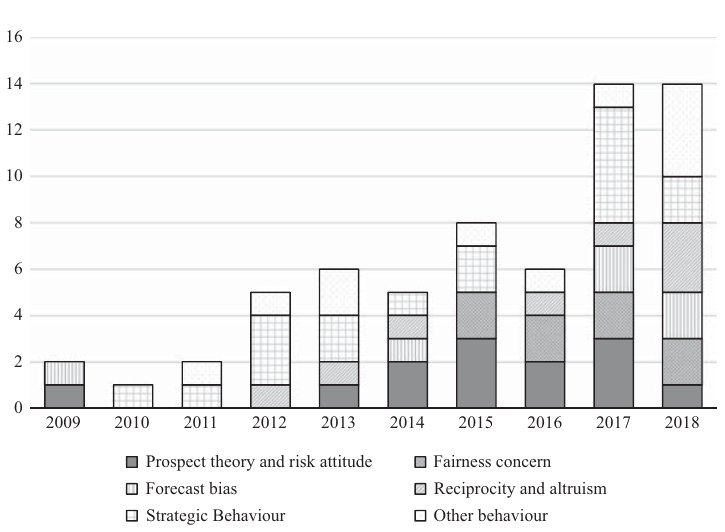
Table V. The number of papers covered in major journals